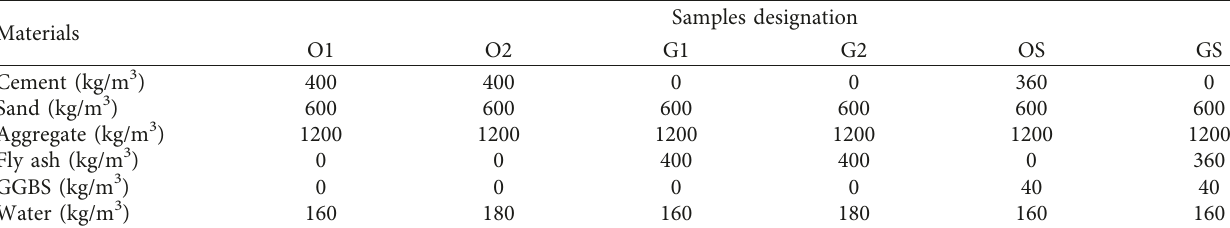
Figure 1: Particle size distribution of (a) fly ash, (b) GGBS, and (c) OPC. Table 1: Mixture proportions.